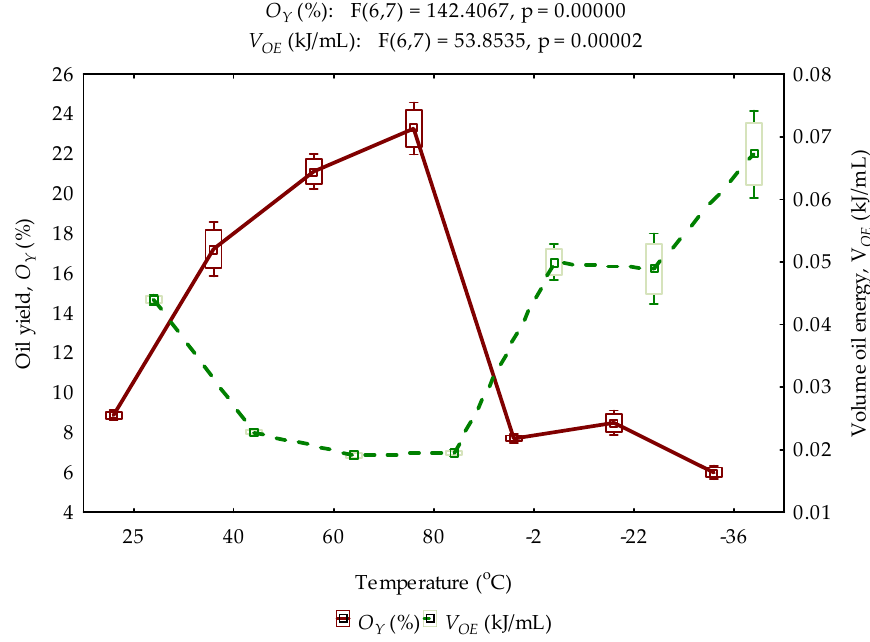
Figure 3. Box plot of oil yield and volume of oil energy grouped by temperature (°C). Table 2. ANOVA results of calculated parameters in relation to heating temperatures.